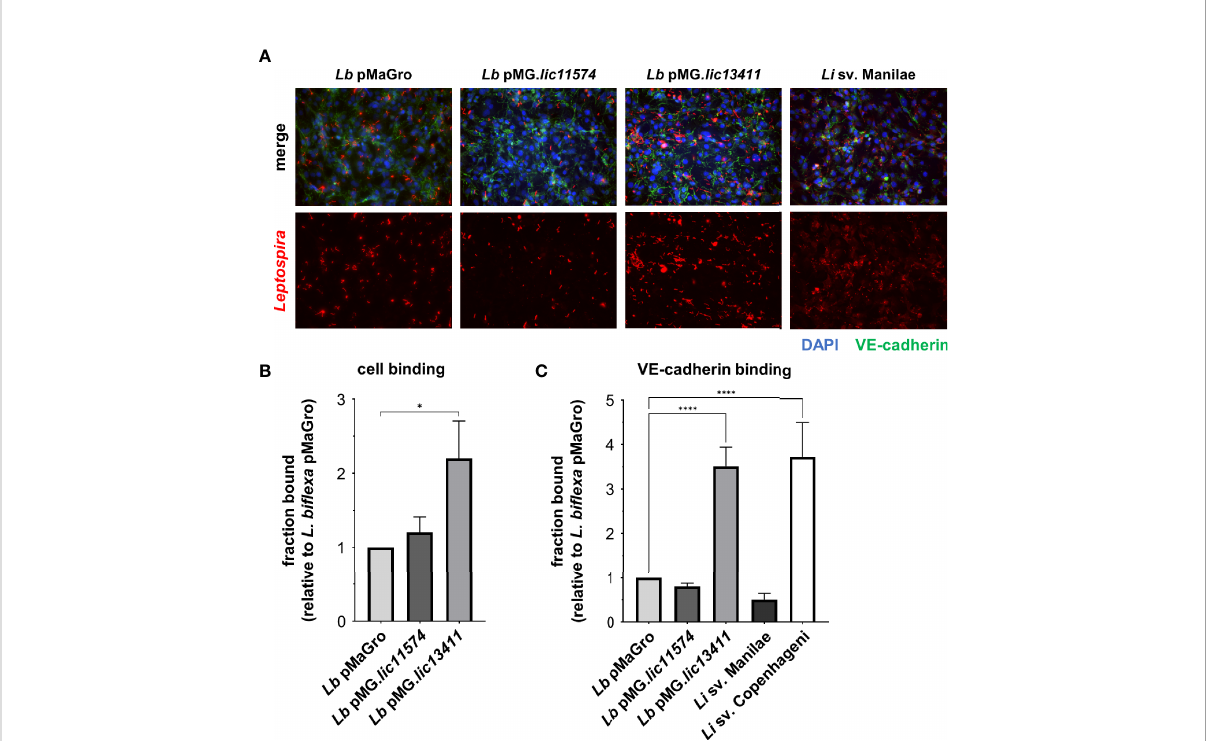
FIGURE 5 LIC13411 production in L. bi fl exa increases binding to HMECs and VE-cadherin. (A) HMECs were grown to con fl uence on glass coverslips and infected at an MOI of 20 for 30 h. Cells were fi xed, stained for VE-cadherin (green) and Leptospira (red), and mounted with Prolong Diamond Antifade Mountant with DAPI (blue). Representative images were selected by an unbiased, blinded observer. L. bi fl exa pMG. lic13411 binds to HMEC cells more than L. bi fl exa pMaGro. (B) HMECs were grown to post-con fl uence, Leptospira strains were added at an MOI of 20, incubated for 1 h, and qPCR was performed to quantify bound bacteria. L. bi fl exa pMG. lic13411 bind to HMECs signi fi cantly more than L. bi fl exa pMaGro. Data represent four independent experiments. (C) VE-cadherin was plated, 3.5 × 10 5 leptospires were added to each well, incubated for 1 h, and qPCR was performed to quantify bound bacteria. L. bi fl exa pMG. lic13411 bound to VE-cadherin signi fi cantly more than L. bi fl exa pMaGro and bound similarly to VE-cadherin as did pathogenic L. interrogans sv. Copenhageni. Data represent fi ve independent experiments, three of which utilized L. interrogans sv. Copenhageni. For all data, technical replicates each day were averaged. Mean ± SEM is plotted. Each column is compared to the L. bi fl exa pMaGro control. *denotes p ≤ 0.05, ****denotes p ≤